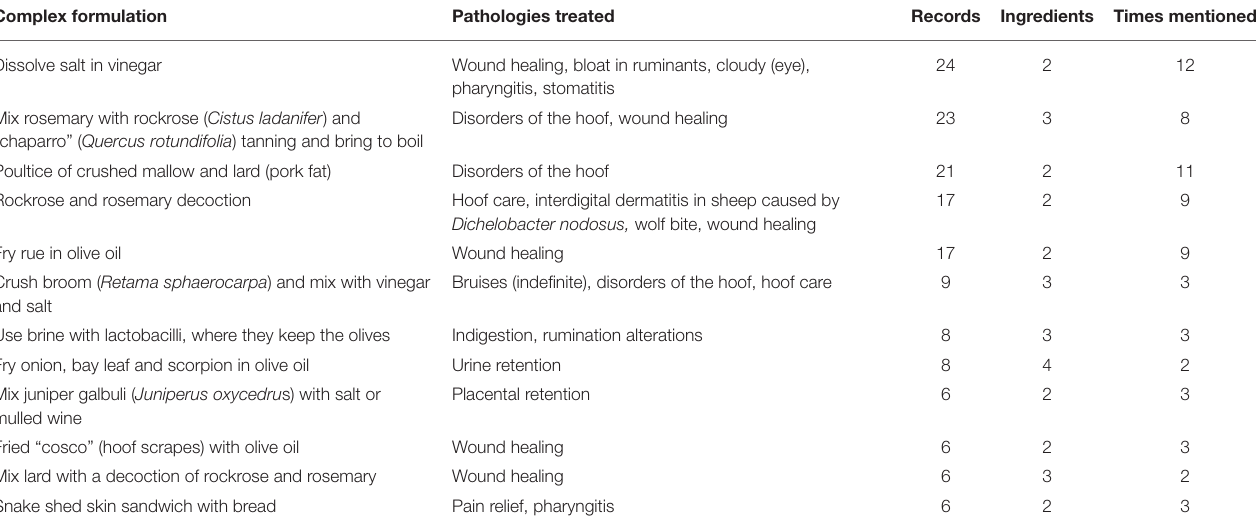
TABLE 4 | Relevant complex